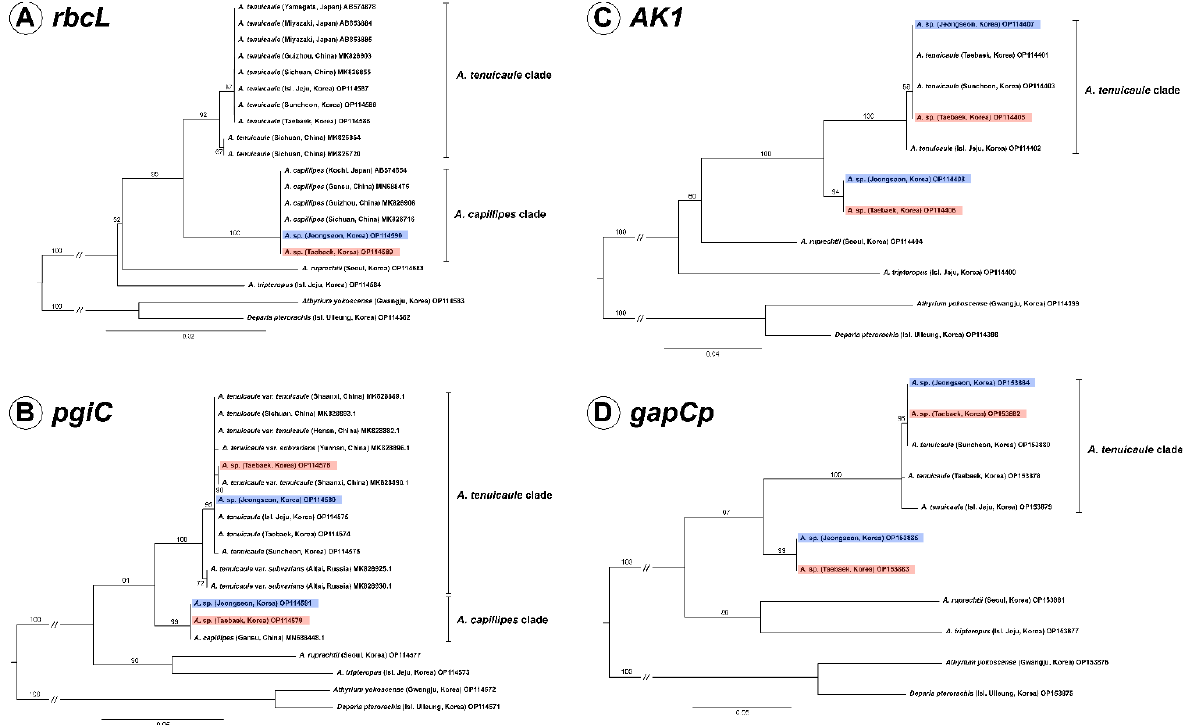
Figure 1. Maximum likelihood phylogeny based on plastid rbcL ( A ) and three nuclear markers, pgiC ( B ), AK1 ( C ), and gapCp ( D ) of Asplenium species and related species. Asplenium sp. is marked in red (Collection Site A) and blue (Collection Site B) boxes. Maximum likelihood bootstrap values are shown above the branches. The scale bar indicates a branch length corresponding to substitutions per